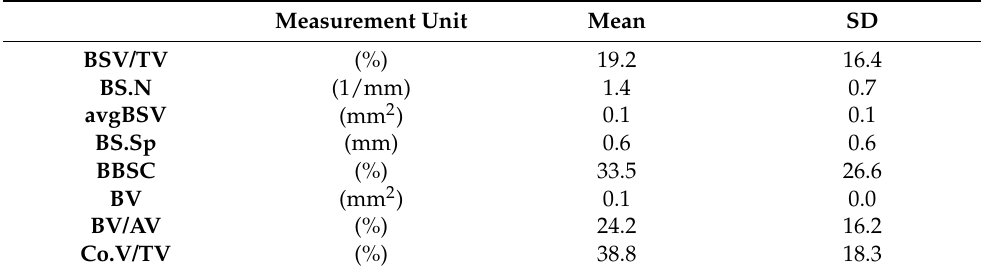
Table 1. Descriptive statistics for histomorphometric parameters measured over the entire length of the biopsies. Values are presented as mean ± standard deviation (SD).